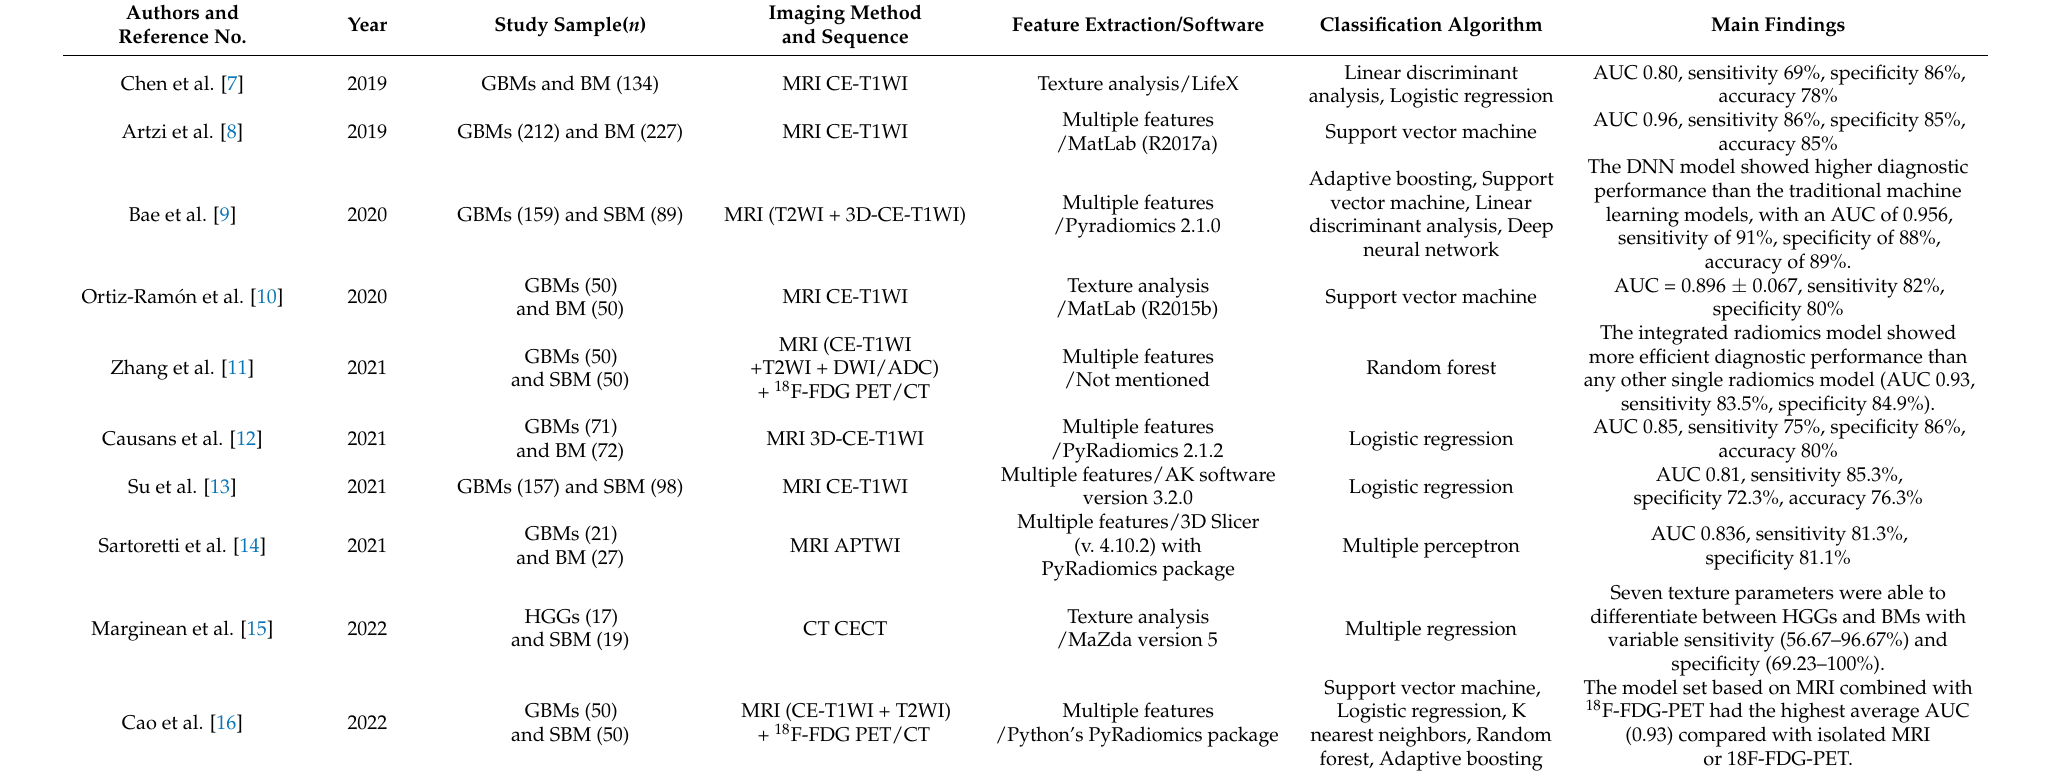
Table 1. Studies Investigating the Role of Radiomics in Differentiation HGGs and